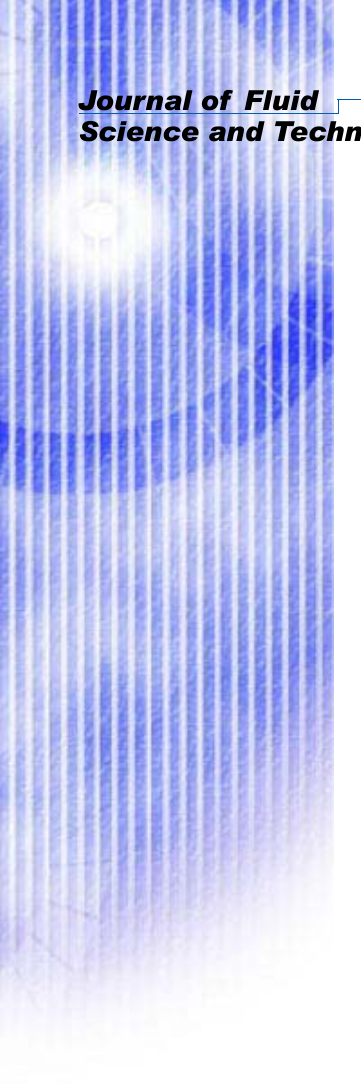
clarified that a great accelerating flow is formed in the wake of the airfoil and a great dynamic thrust acts on the airfoil (12)(13) . Furthermore, the vortex streets on the heaving